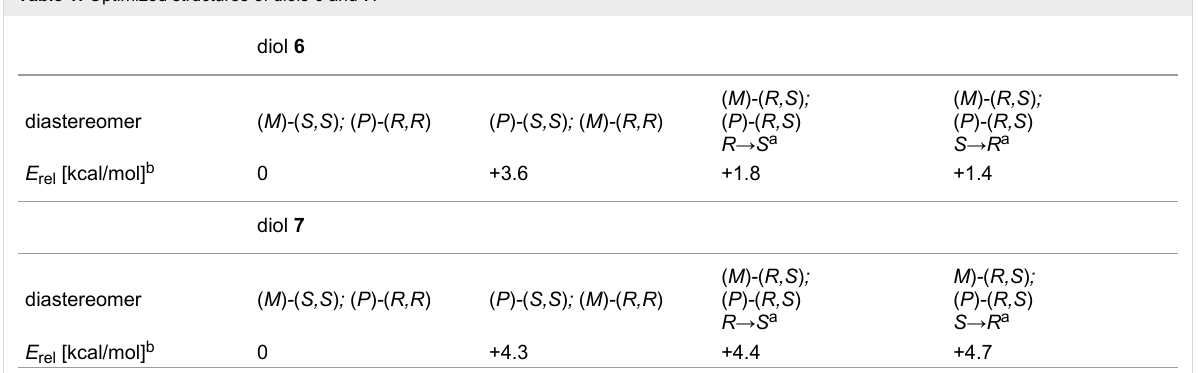
Table 1: Optimized structures of diols 6 and 7